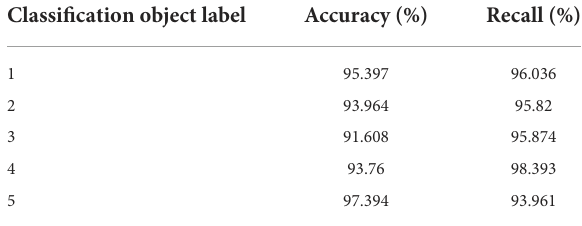
TABLE 2 Comment on preprocessing experimental results by adding artificially defined